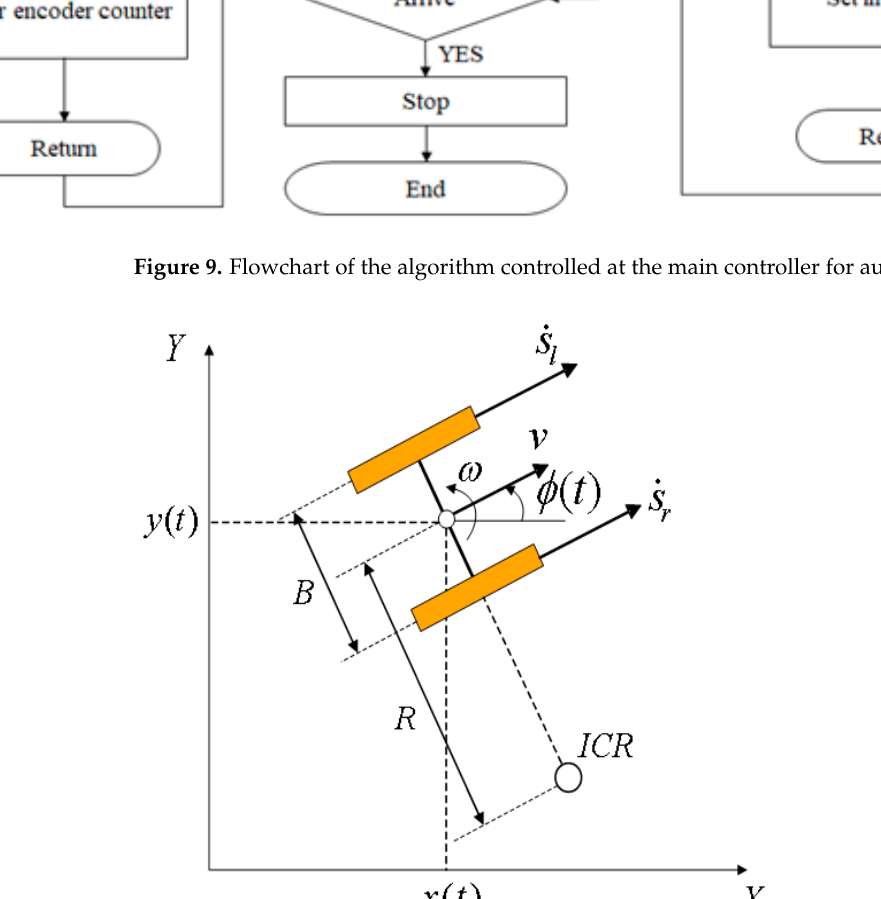
Figure 10. Dynamics variables for a mobile robot ( , v : linear velocity of robot, ω : angular velocity of robot, ICR: center of rotation, B : distance between wheels).